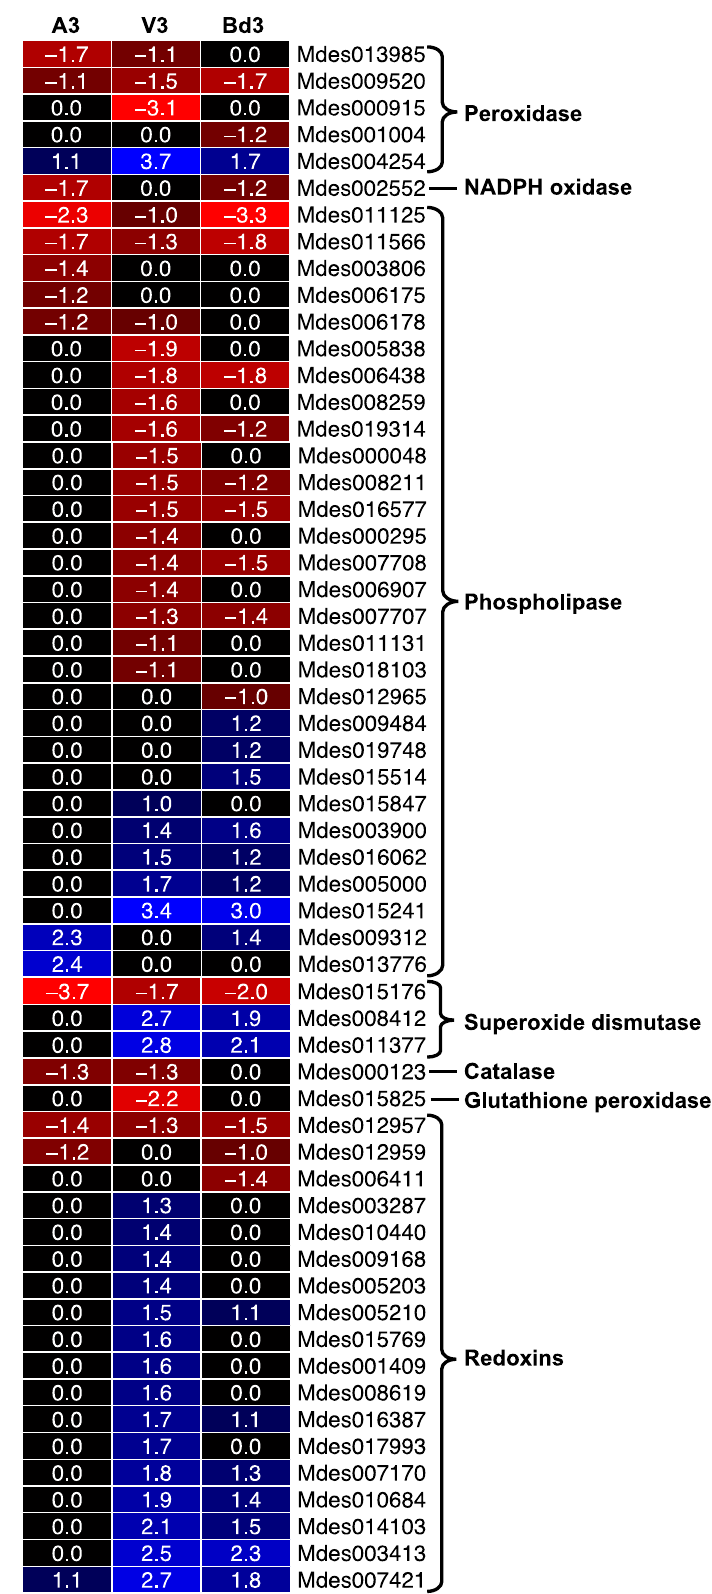
Figure 12. Differential expression of genes involved in oxidative stress in Hessian fly larvae 3 days after hatch (DAH). Heatmap depicts the expression profiles of genes encoding enzymes involved in reactive oxygen species (ROS) generation (peroxidases, NADPH-oxidase, phospholipases) and